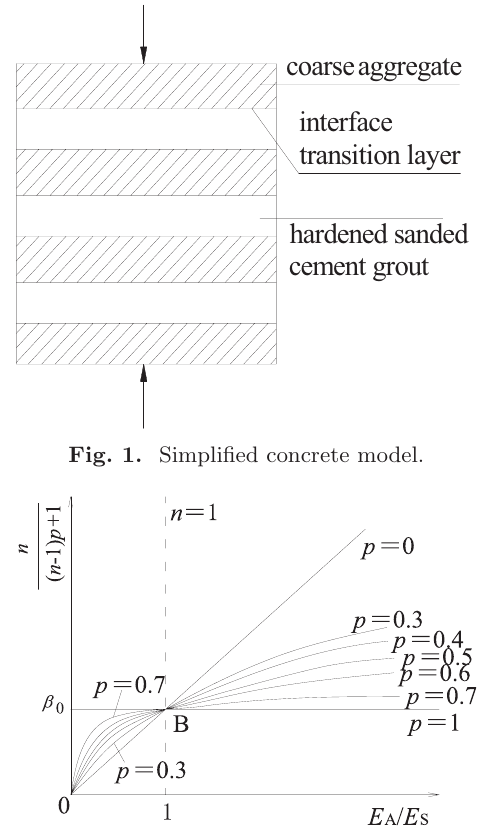
Fig. 1. Simplified concrete model.